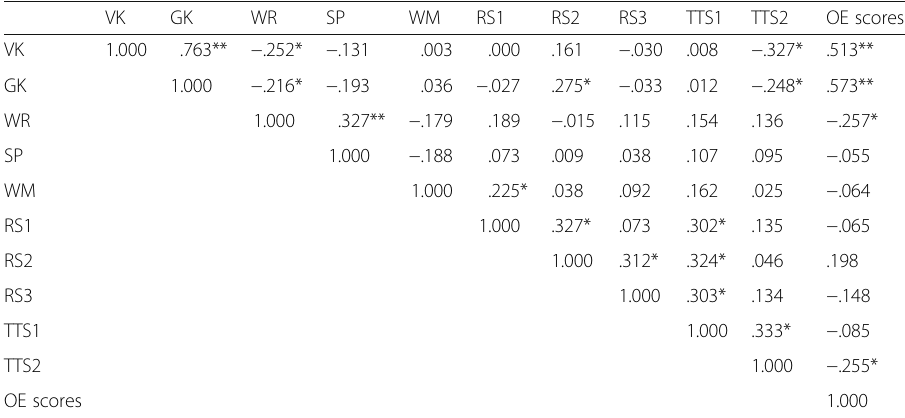
Table 9 Correlations among sub-reading components and OE reading test scores VK